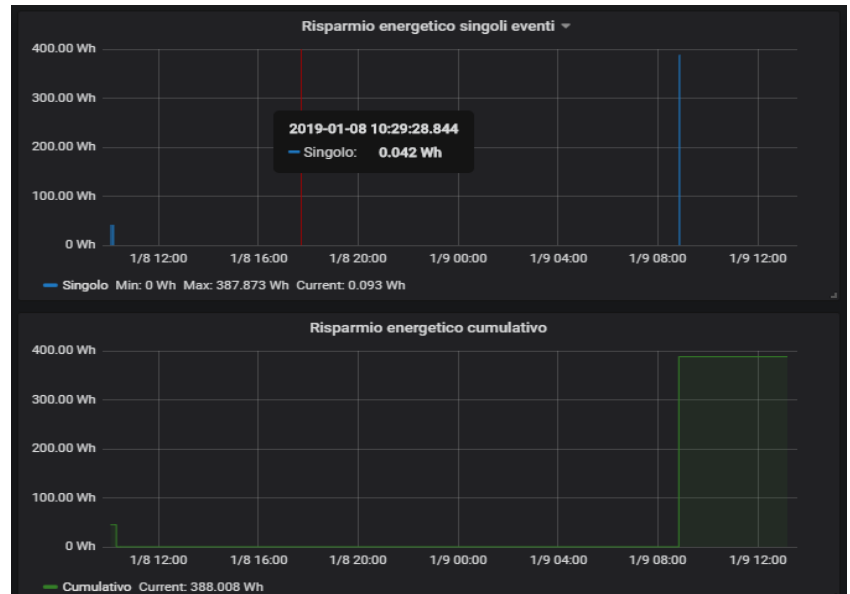
Figure 7. Inner cabin and outside proximity localization panels.